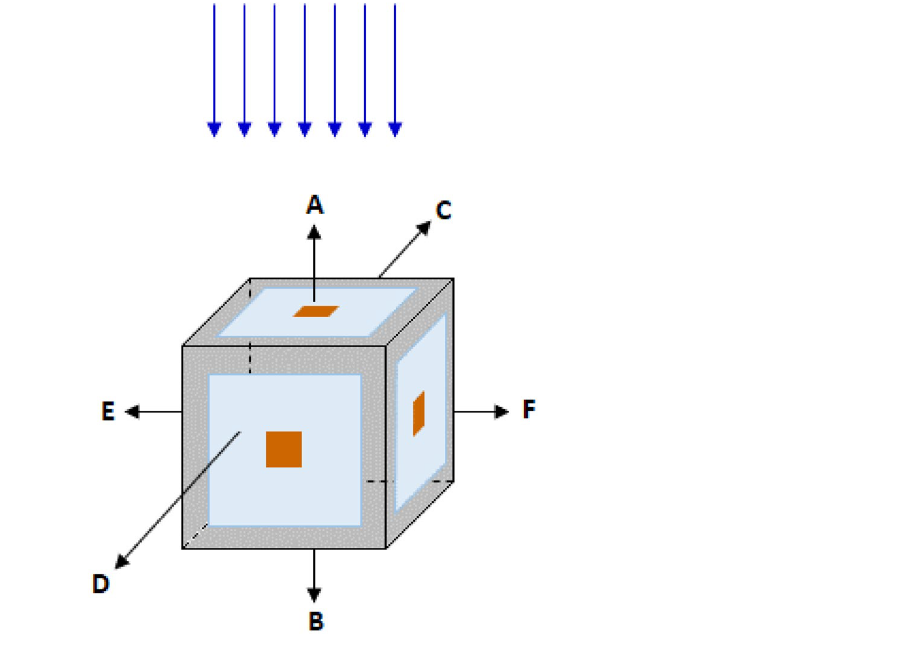
Figure 1. Schematic design of a PE cube with 6 PCTD/ 10 B detectors on sides A, B, C, D, E and F sides of the